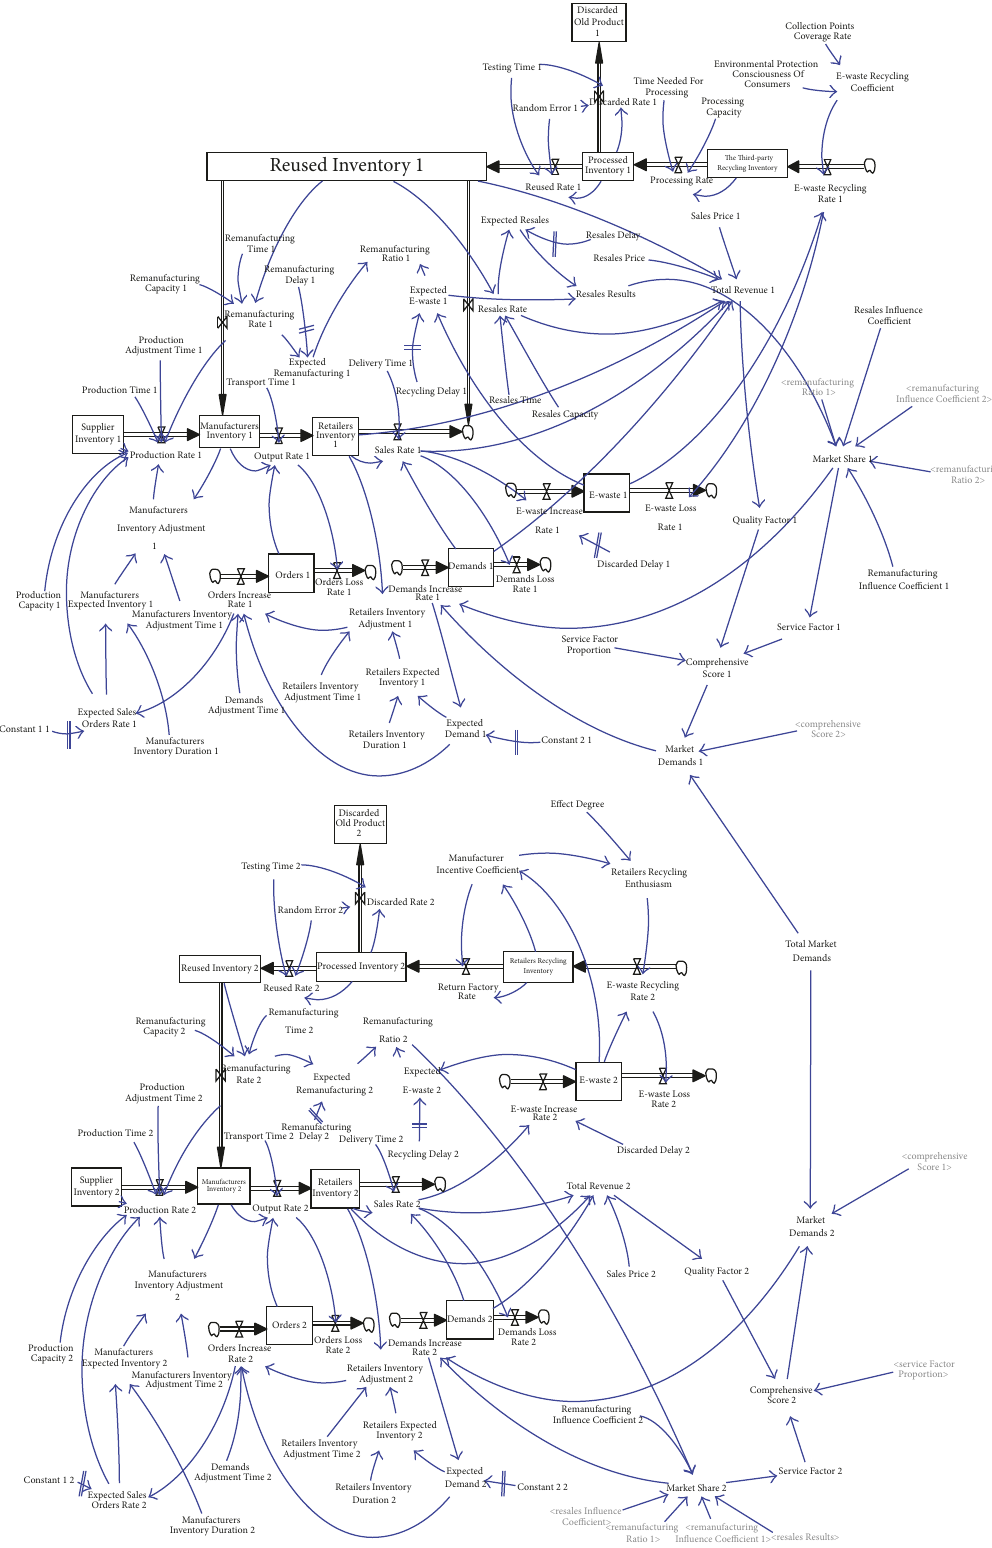
Figure 3: Across-chain competition system dynamics